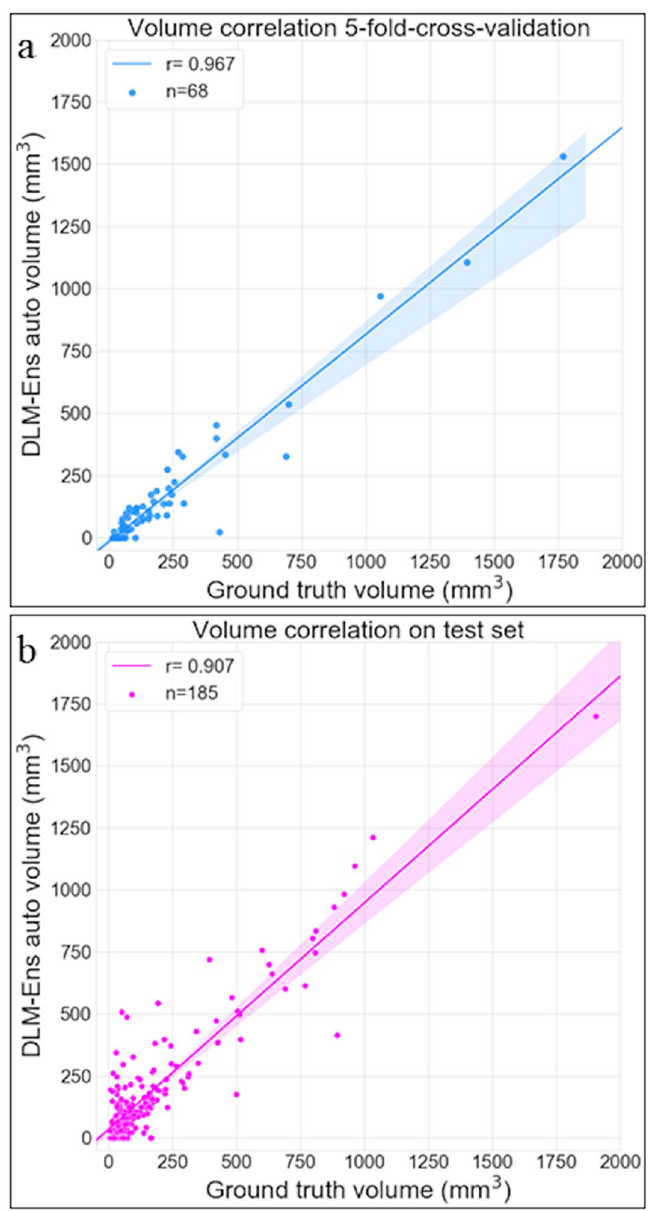
Figure 4. Aneurysm volume correlation plots per patient between manually defined reference standard and the automatically obtained segmentations for validation (a) and test set (b) of DLM-Ens using Pearson correlation